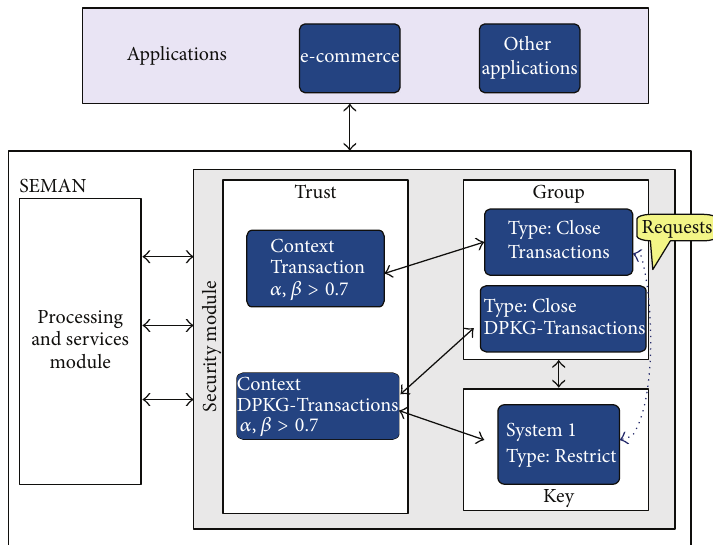
Figure 11: Restrict